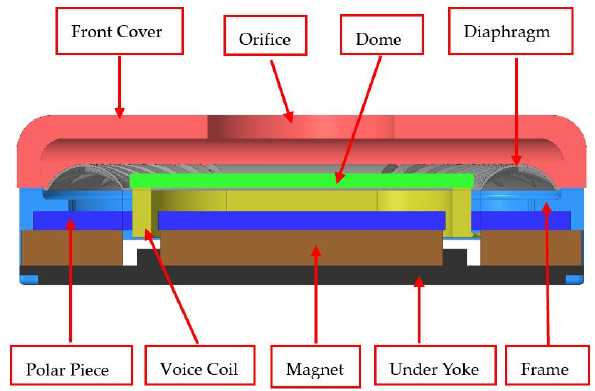
Figure 1. Cross-sectional view of a moving-coil miniature